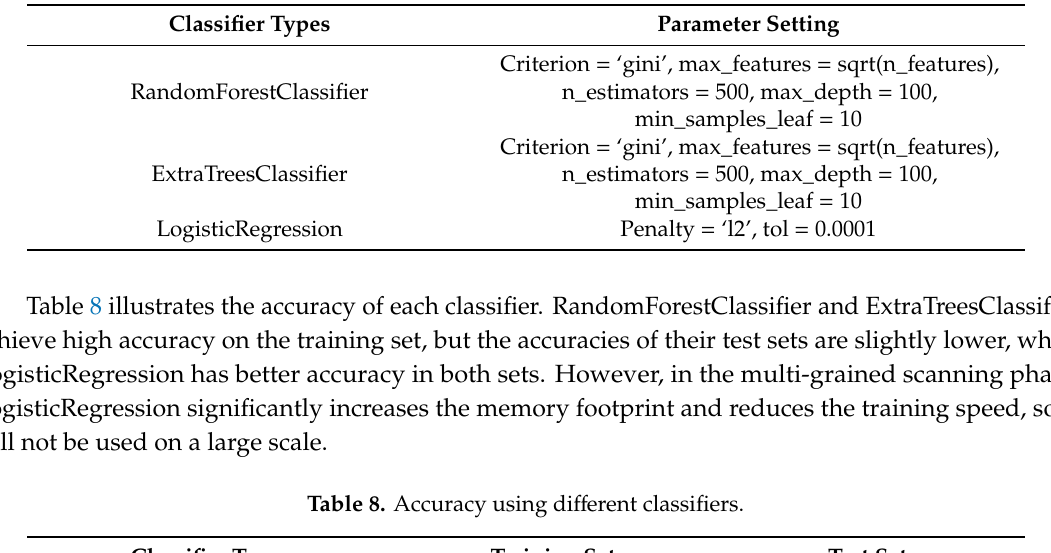
Table 7. Original experimental parameter setting of multi-grained scanning.